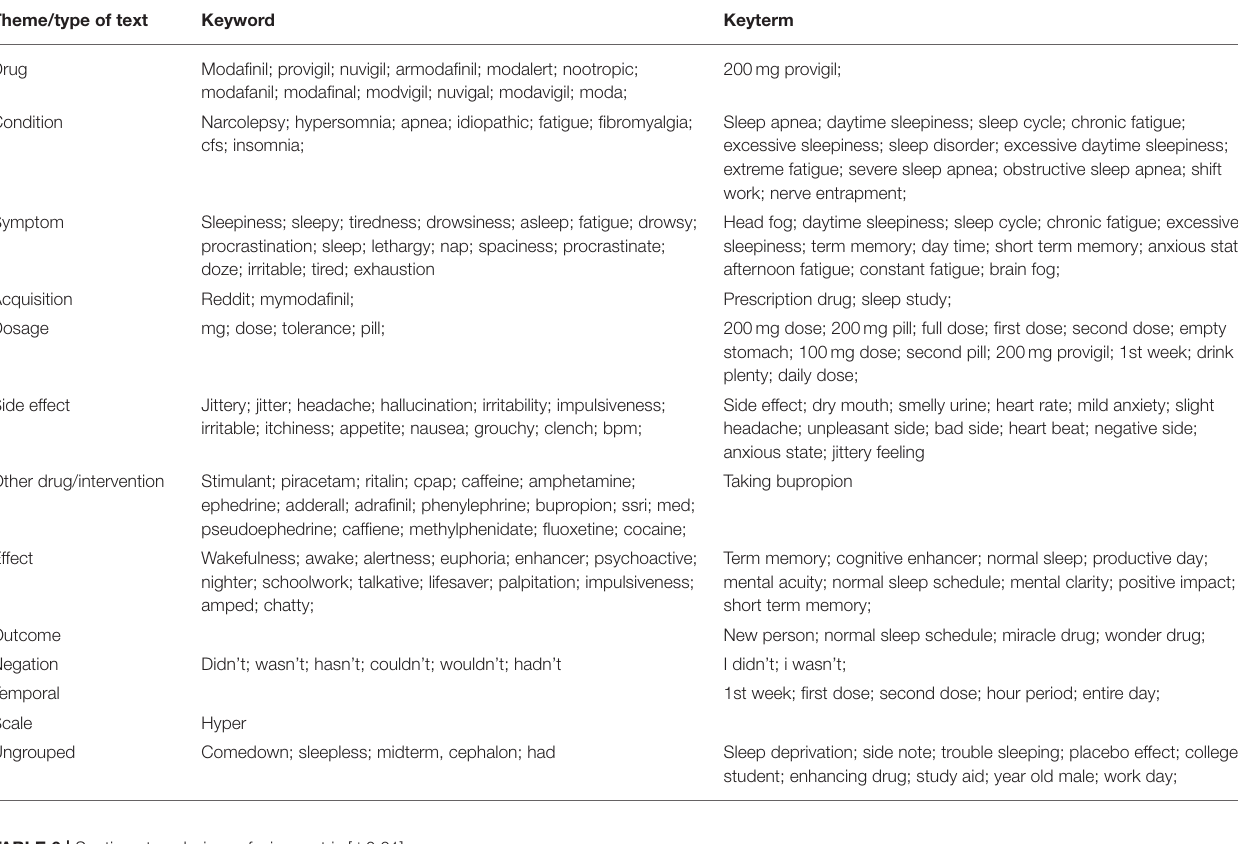
TABLE 5 | 100 highest frequency keywords and keyterms by topic. Theme/type of text